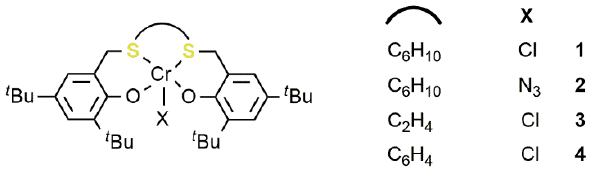
Figure 8. Chromium(III)-[OSSO] catalysts 1–4 [59].